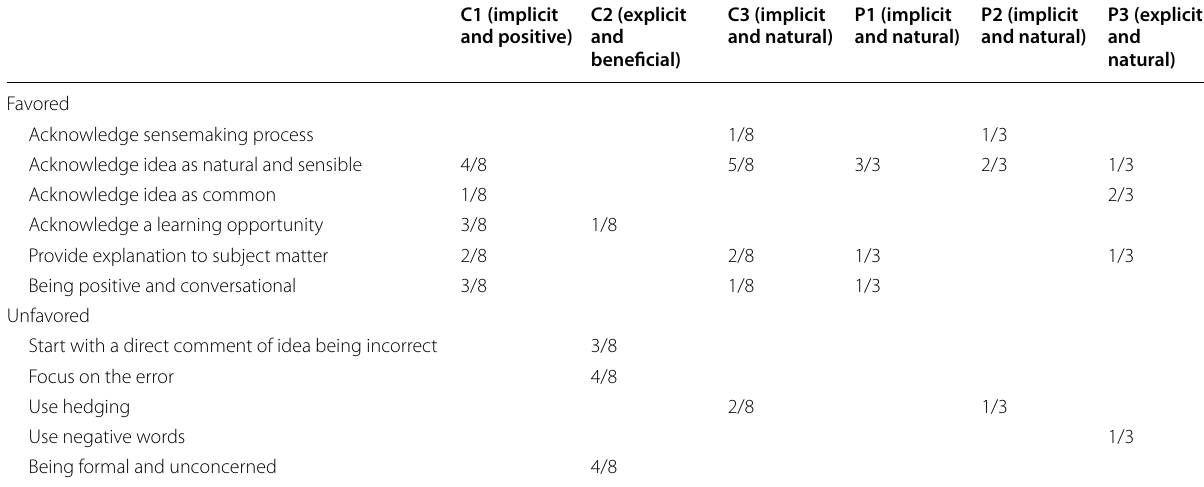
The total number of interviews for chemistry is 8, and the total number of interviews for physics is 3